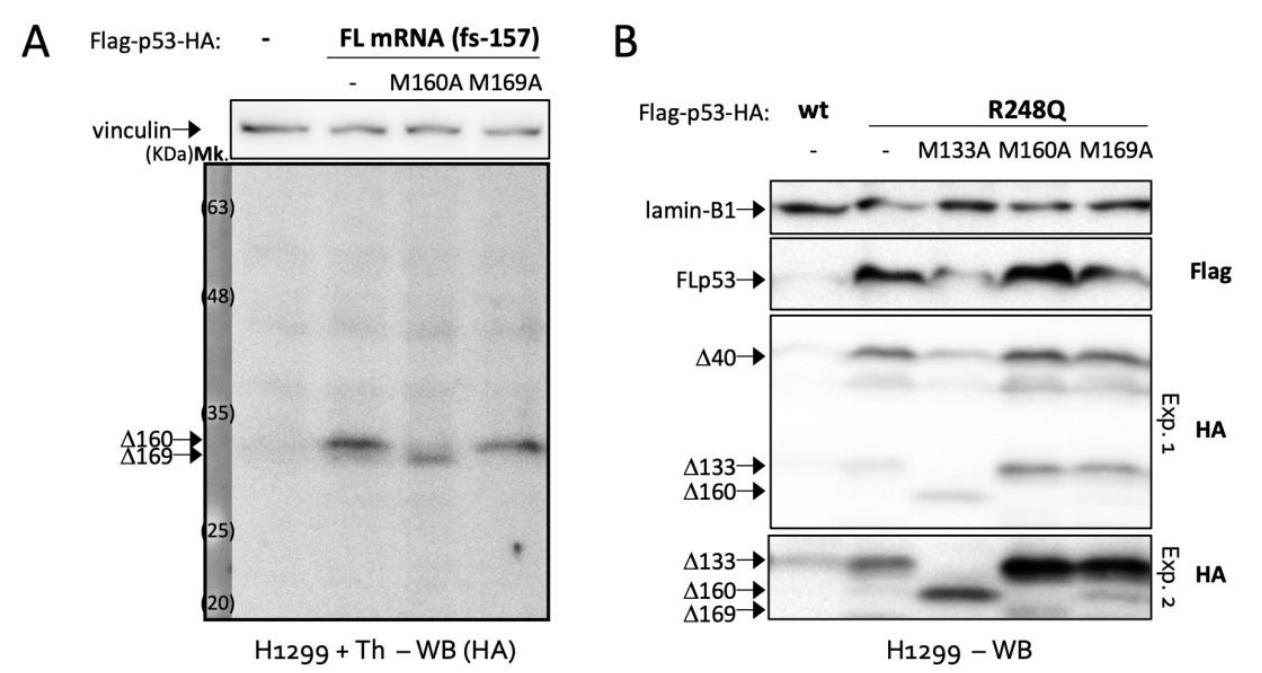
Figure 3. Full-length p53 mRNA expresses ∆ 169p53 isoform upon stress or mutation: ( A ) Western blot analyses (WB) of H1299 cells expressing or not full-length (FL) p53 mRNA, as indicated, and treated with Th (16 h). fs indicates a frameshift mutation of one nucleotide at codon 157 and M160A and M169A indicate mutations in codons 160 and 169, respectively. ( B ) WB of H1299 cells expressing wild-type (wt) or mutant R248Q p53 mRNAs with or without mutated translation start sites (TIS) for ∆ 133p53, ∆ 160p53 or ∆ 169p53 (–, M133A, M160A or M169A). Flag, WB against Flag tag; HA, WB against HA tag. Shown are representative data of at least three independent